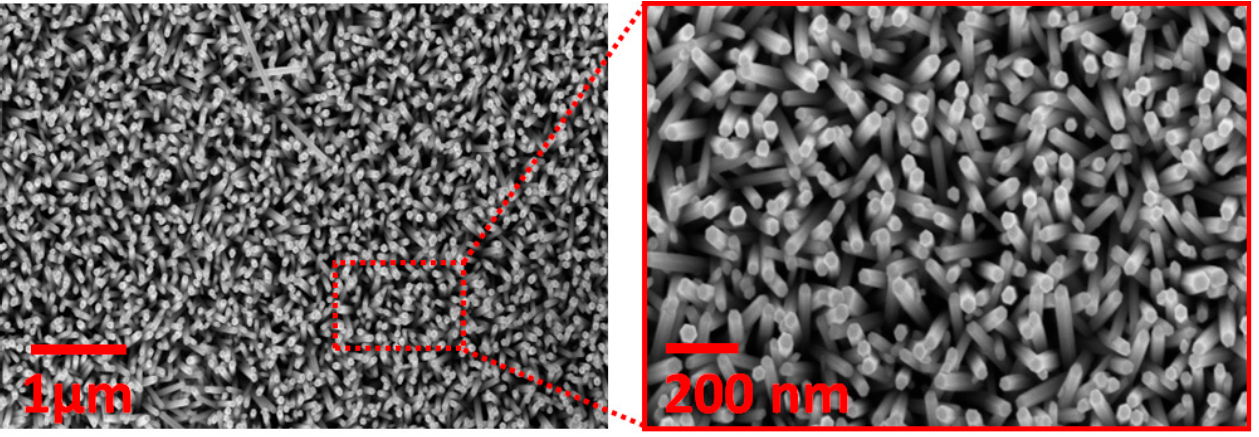
Figure 1. FE-SEM images of ZnO-NRs. FE-SEM images of hydrothermally grown ZnO-NRs, showing typical dimensions ranging between 40 and 50 nm in diameter, and lengths of ∼ 800 nm after sonication.